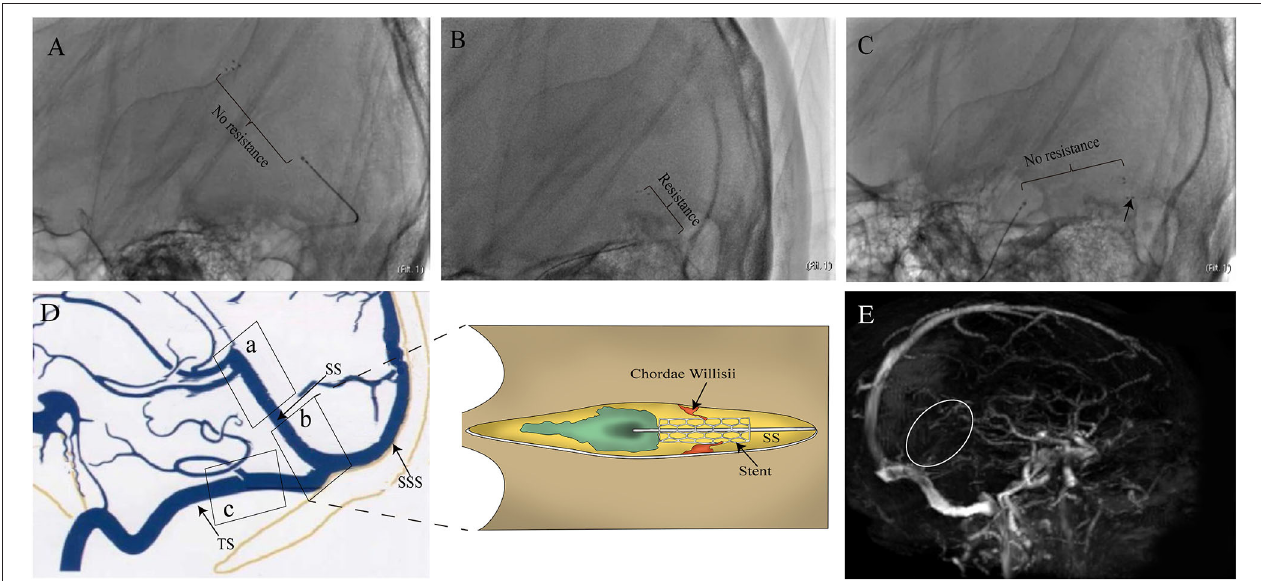
FIGURE 1 | Images of the case that motivated this study. (A) 24-year-old woman with epilepsy and coma was admitted to the Department of Neurosurgery. The patient underwent cerebral angiography, which showed filling defects involving the SS and deep venous system. The patient then underwent mechanical thrombectomy with a stent. Resistance (from large to small suddenly) was encountered and led to dramatic movement of the patient’s head during the withdrawal of the device in PoSS. The device was seemingly resisted by some anatomical structure within the sinus. No resistance was experienced when the stent moved through both AnSS and TS (B,C) . Although low-molecular-weight heparin and warfarin were used after surgery, the patient’s consciousness returned to lethargy with recurrence of SS thrombosis (white circle) in 2 weeks after surgery (E) . The illustration of suspected causes of resistance in the SS (D)